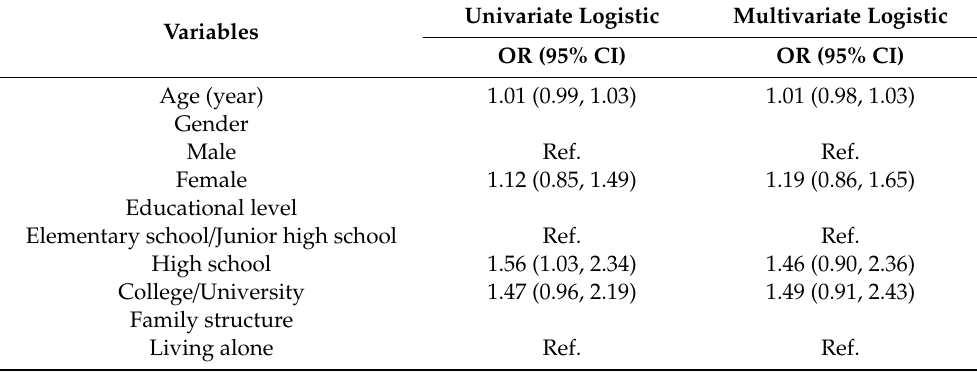
Table 5. Univariate and multivariate logistic regression for factors associated with undergoing regular dementia screenings ( n =